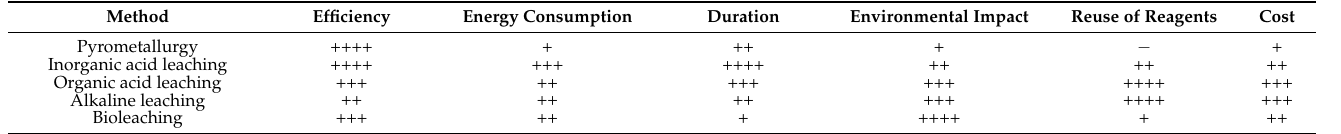
Table 4. Qualitative performance comparison of the common LIBs recycling